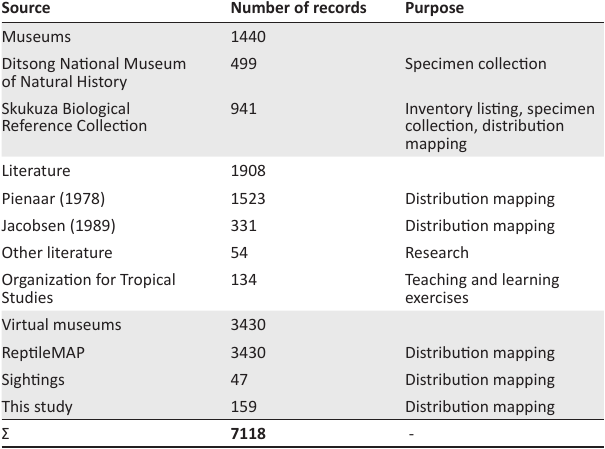
TABLE 1: Sources of reptile occurrence records used in this